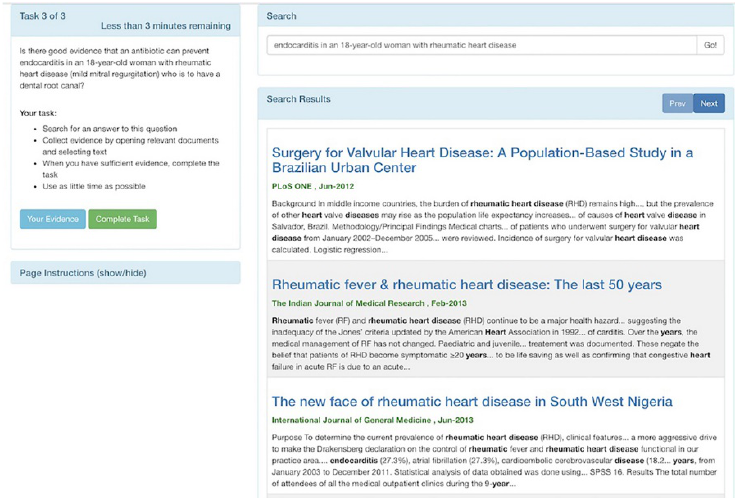
Figure 2 Screenshot of Taskiir, a custom medical literature search engine